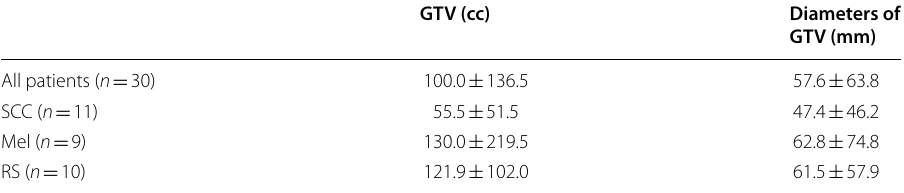
GTV gross tumor volume, SCC squamous cell carcinoma, Mel melanoma, RS rhabdomyosarcoma